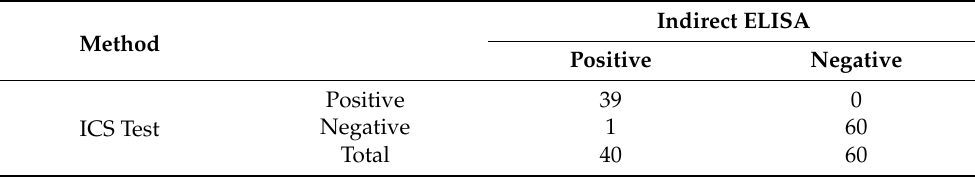
Table 1. Determination of antibodies in non-infected and infected mice serum using indirect ELISA and ICS